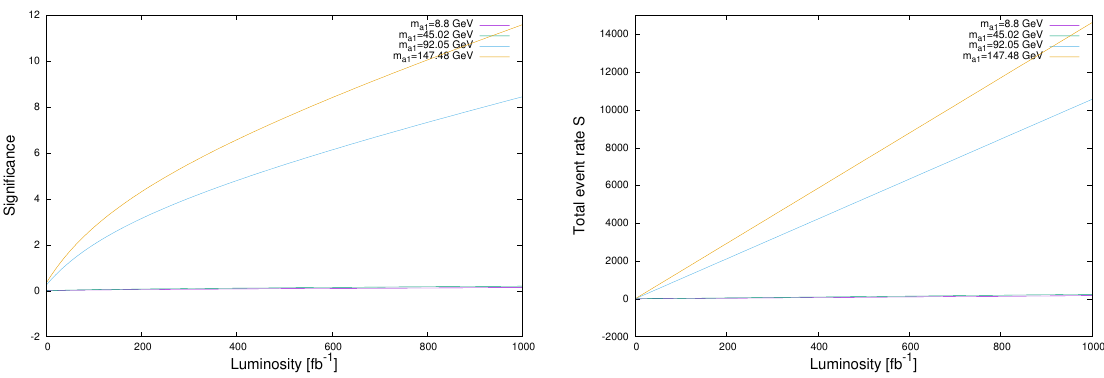
√ B ( left plot ) and the signal event rate S ( right plot ) of the process bg → a 1 b → b τ + τ − as Figure 5. The signal significance S / functions of the integrated luminosity for the four benchmark points mentioned in Table 1. The lines for both m a 45.02 GeV may be hardly visible but they were added for